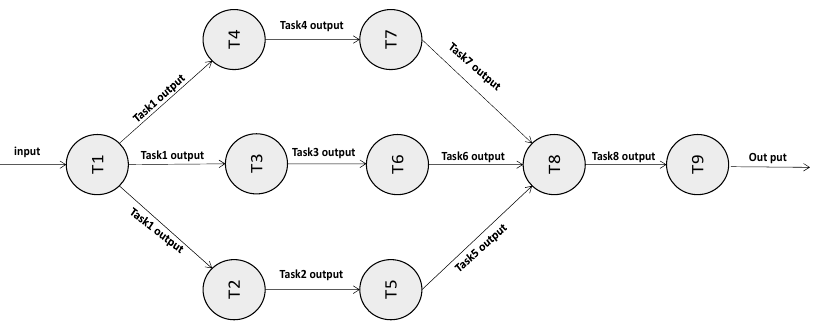
Figure 1. Sample Workflow with nine tasks.